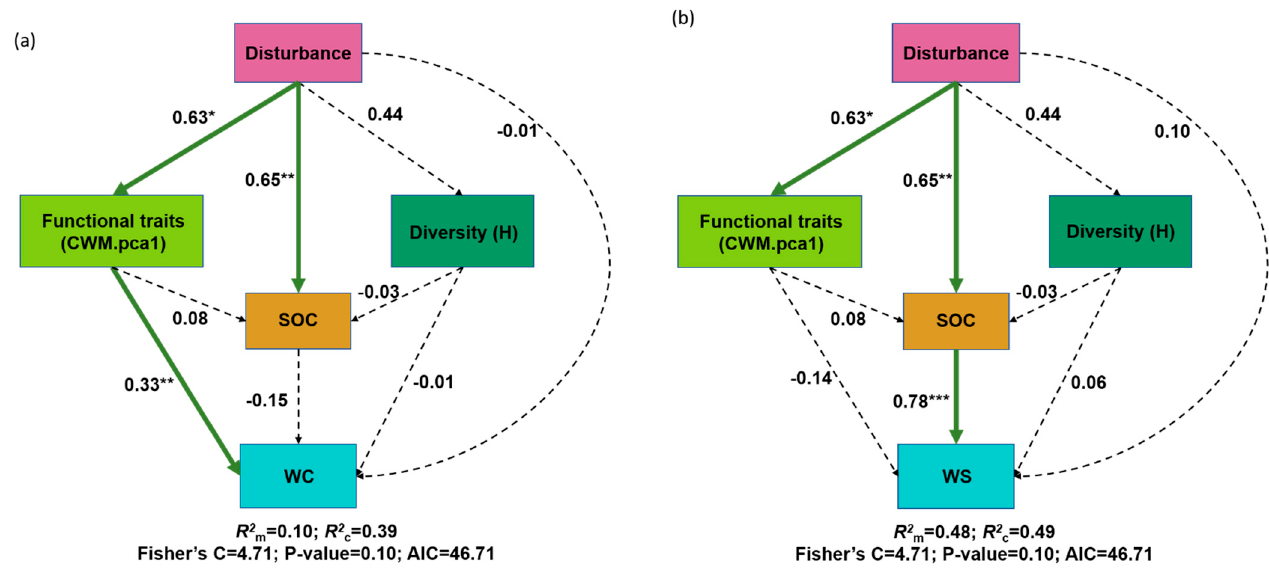
Figure 4. Pathways showing how logging disturbance affects WC ( a ) and WS ( b ) based on piece ‐ wise structural equation models (pSEMs). Numbers adjacent to arrows represent the effect size of the relationship. Continuous arrows indicate significant pathways whereas dashed arrows indicate insignificant pathways. The significance of relationships was also given (* p < 0.05, ** p < 0.01, *** p < 0.001).